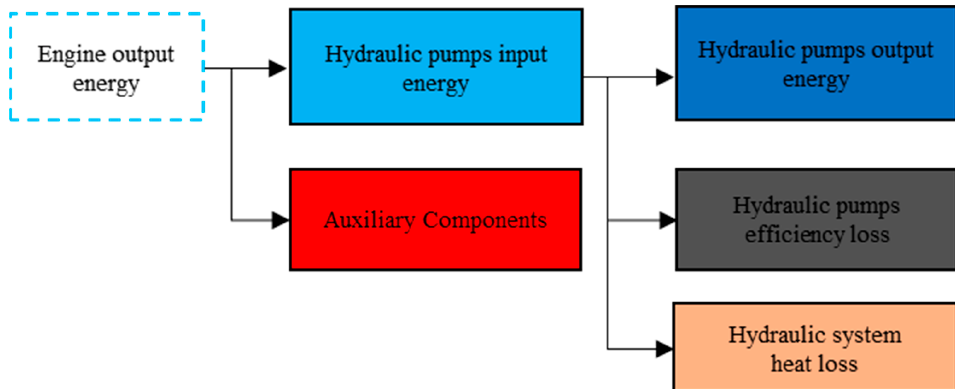
Figure 4. Excavator pump energy flow.